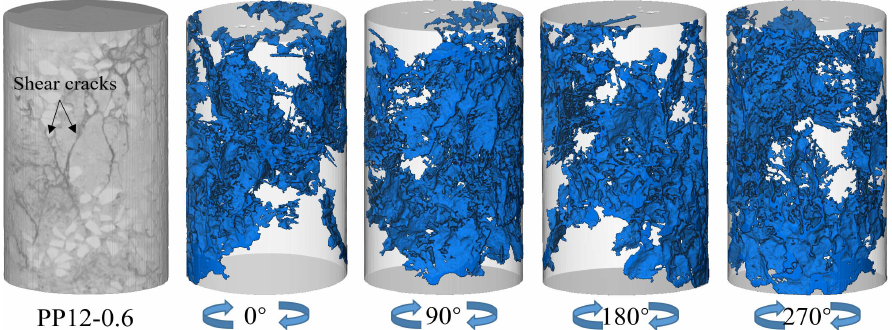
Figure 10. 3D reconstructed image of the cracks in PP12-0.6.